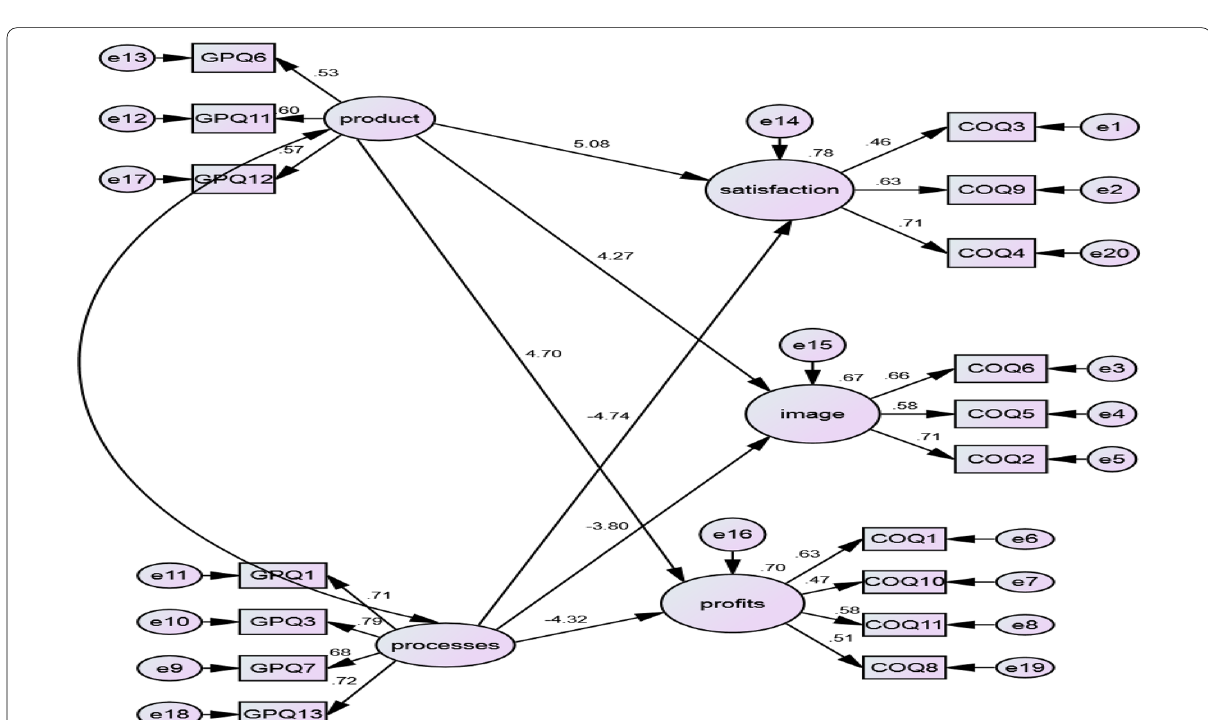
Fig. 5 The structural